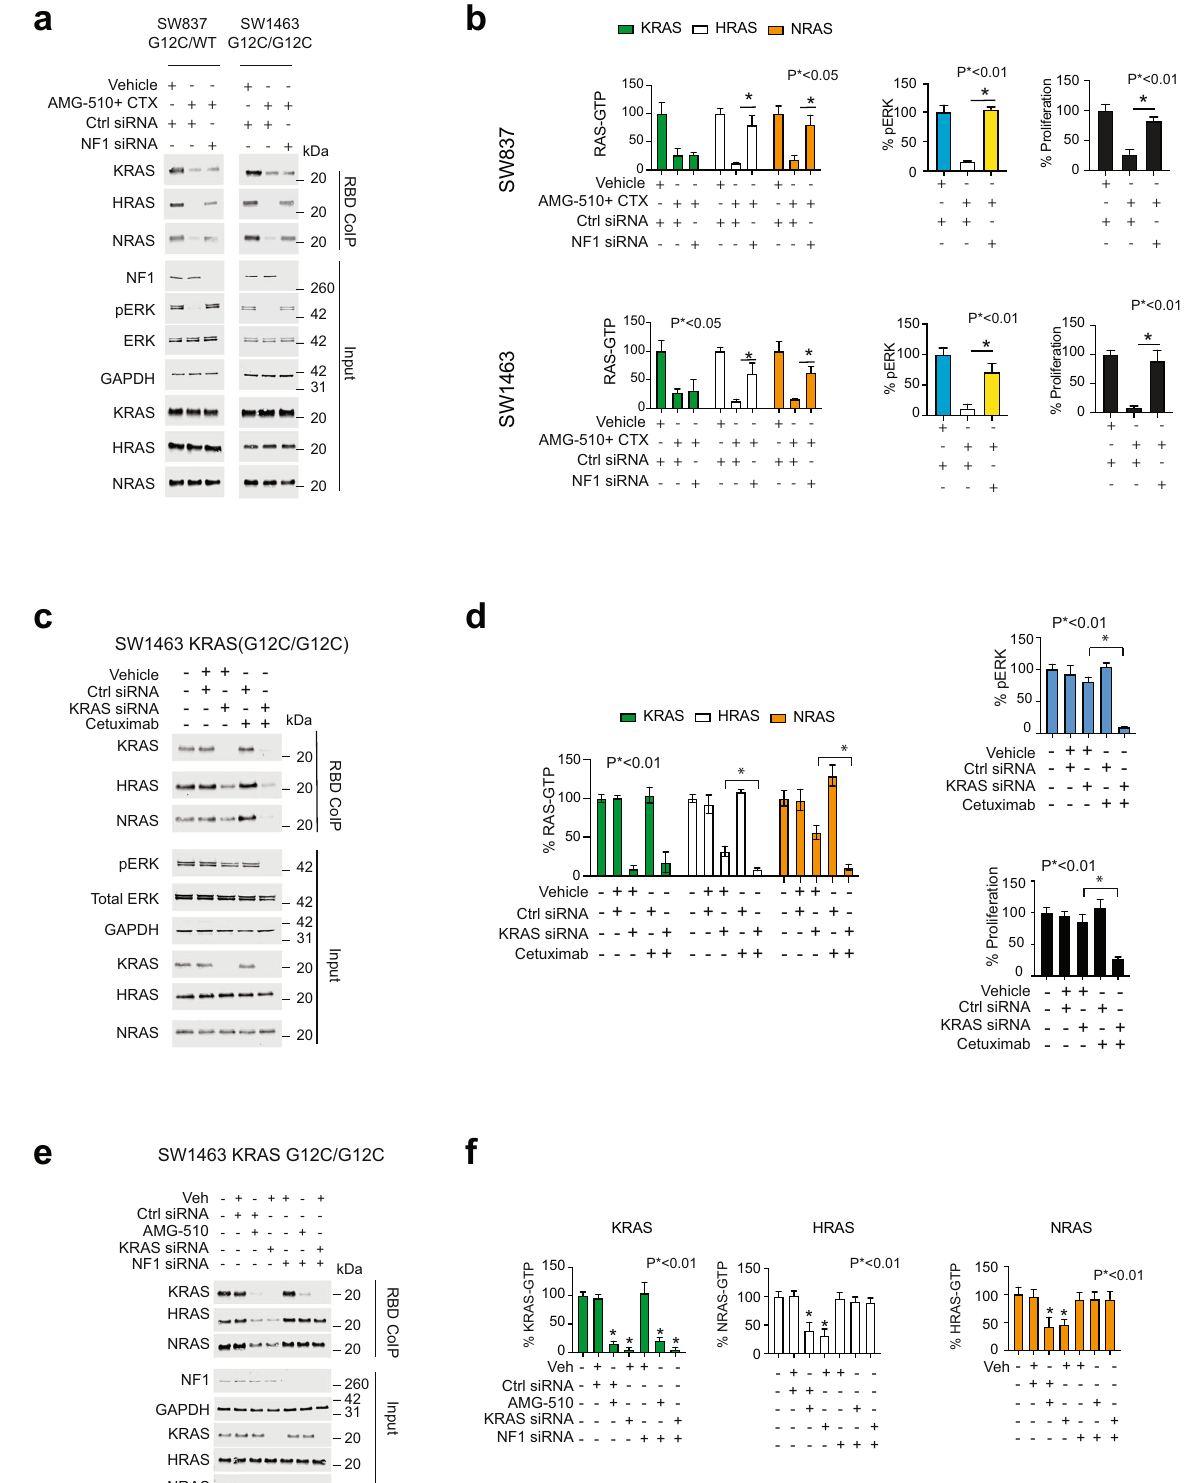
targeting of WT and mutant RAS. That wild-type RAS signaling is frequently elevated in the presence of mutant RAS has extensive experimental evidence 13,16,19 – 21 , yet it is an aspect of RAS signaling that is often overlooked when mutant RAS cancers are considered 22